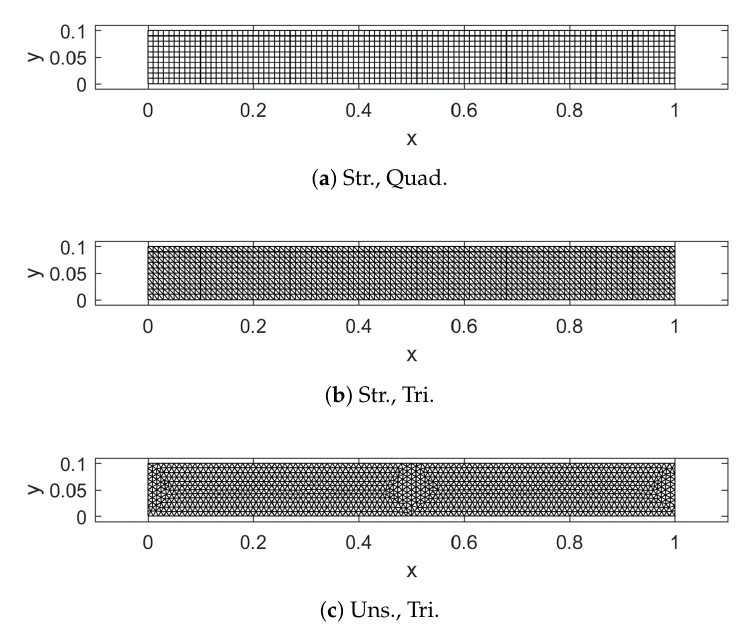
Figure 3. Three different meshes for shock tube problem: ( a ) structured mesh with quadrilateral elements; ( b ) structured mesh with triangular elements; ( c ) unstructured mesh with triangular